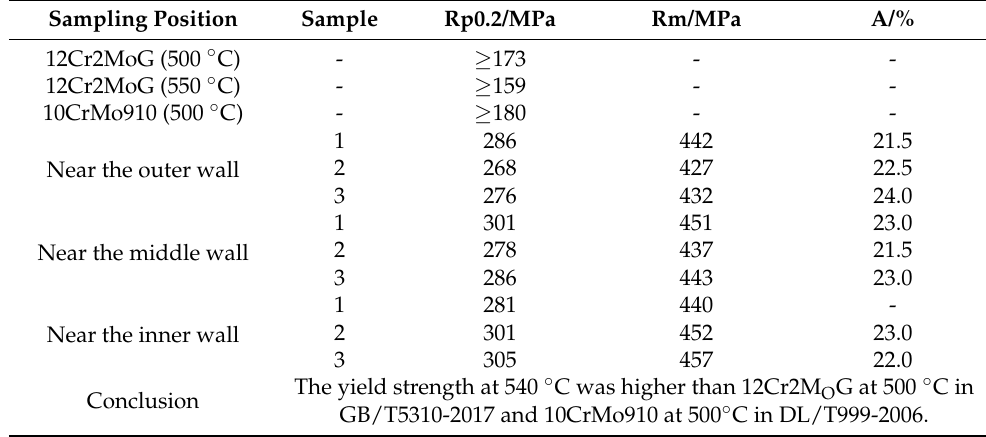
Figure 2. The size of the sample at a high temperature (mm). Table 5. The results of the tensile test at 540 °C.